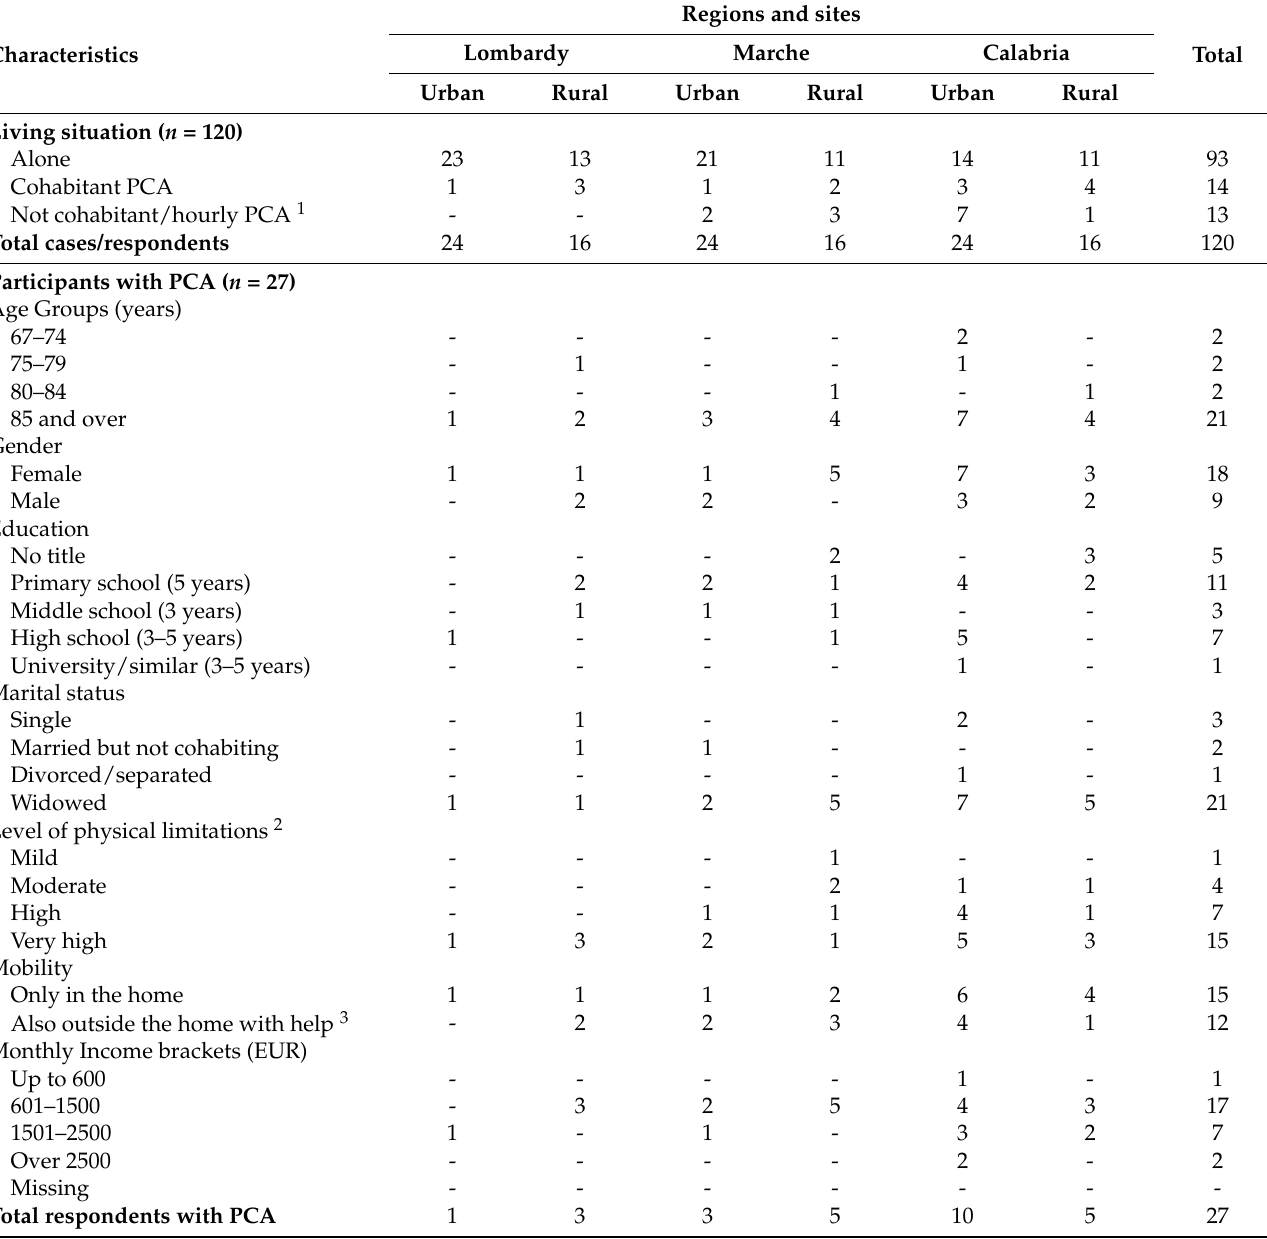
Table 2. Sample characteristics (absolute